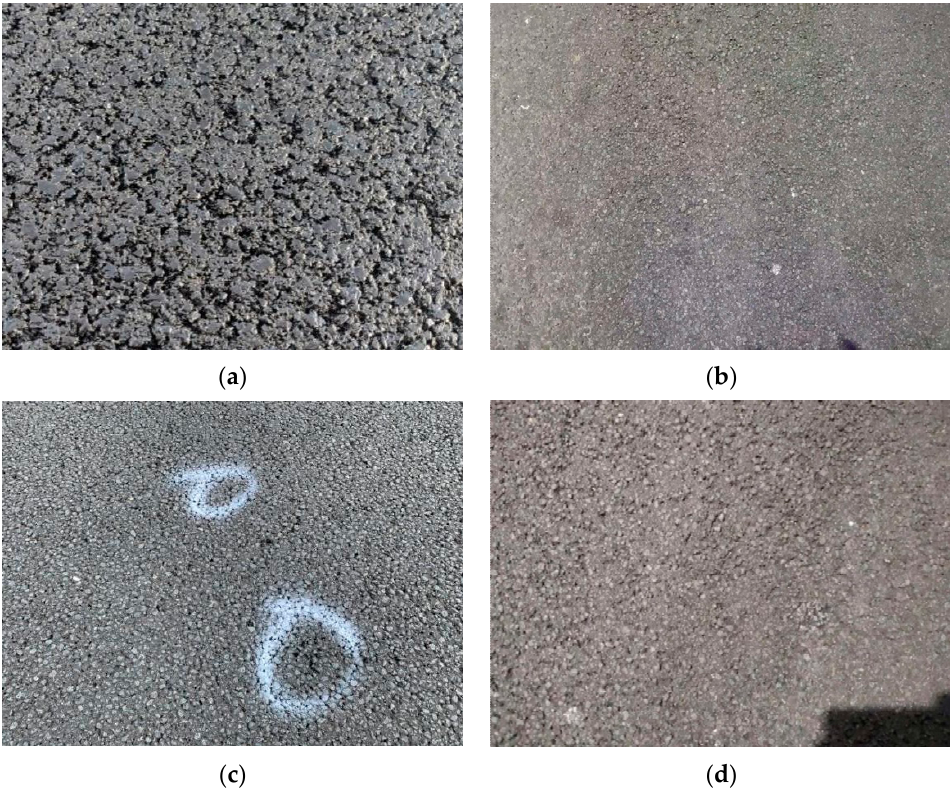
Figure 6. Pavement conditions of steel bridge deck during different periods: ( a ) pavement just after construction; ( b ) pavement 18 months after opening to traffic; ( c ) pavement 23 months after opening to traffic; ( d ) pavement 28 months after opening to traffic.